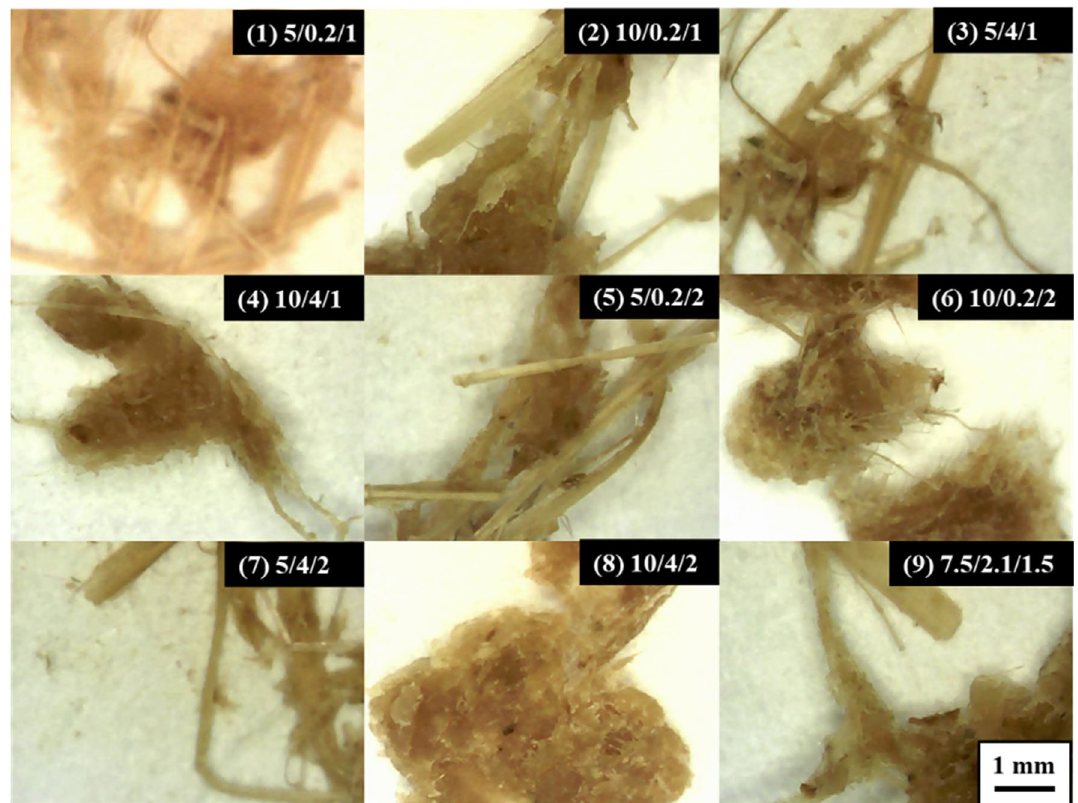
Figure 3. Whole spectral micrographs of rice straw semi-chemical mechanical pulp at a magnification of 50x. Note: The graph set number represents NaOH dosage (%), enzyme dosage (%) and refining time